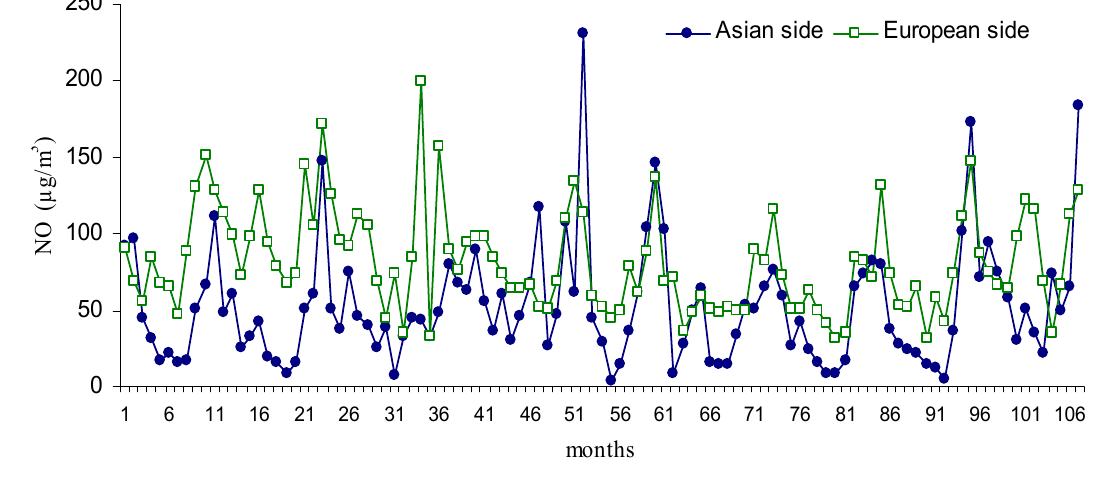
Figure 5. Monthly changes of NO